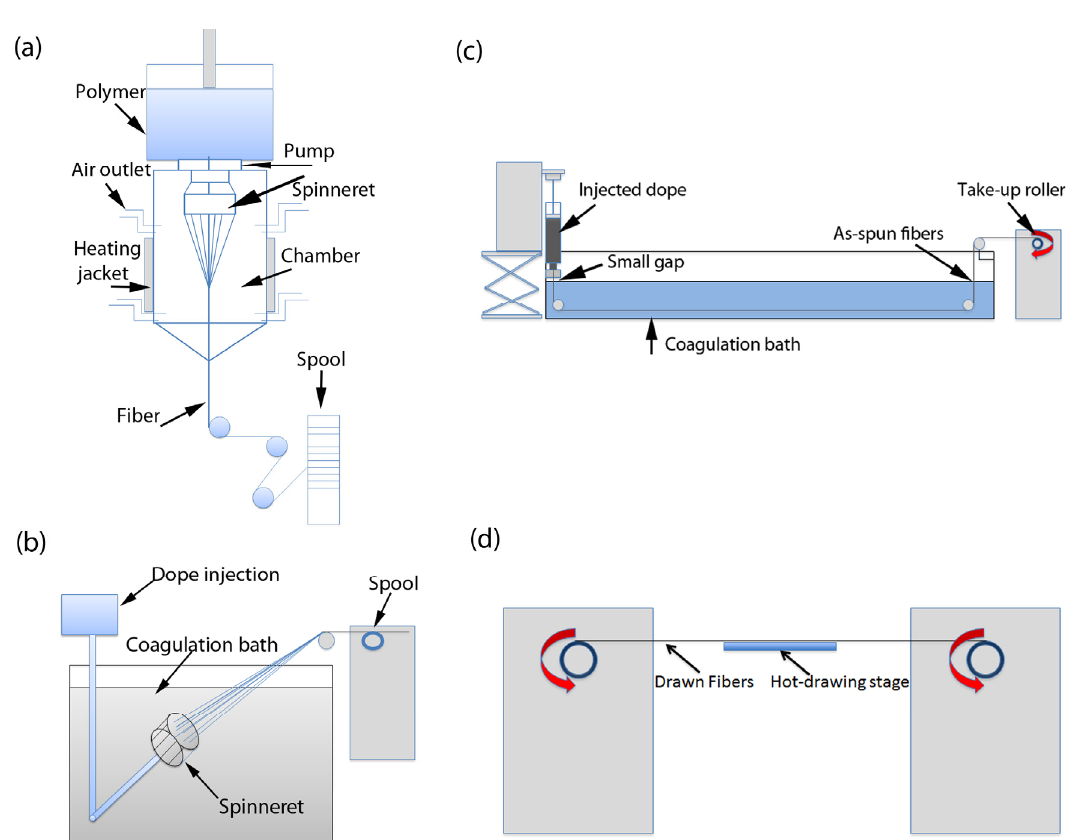
Figure 1. Schematics representing the various fiber processing methods ( a )